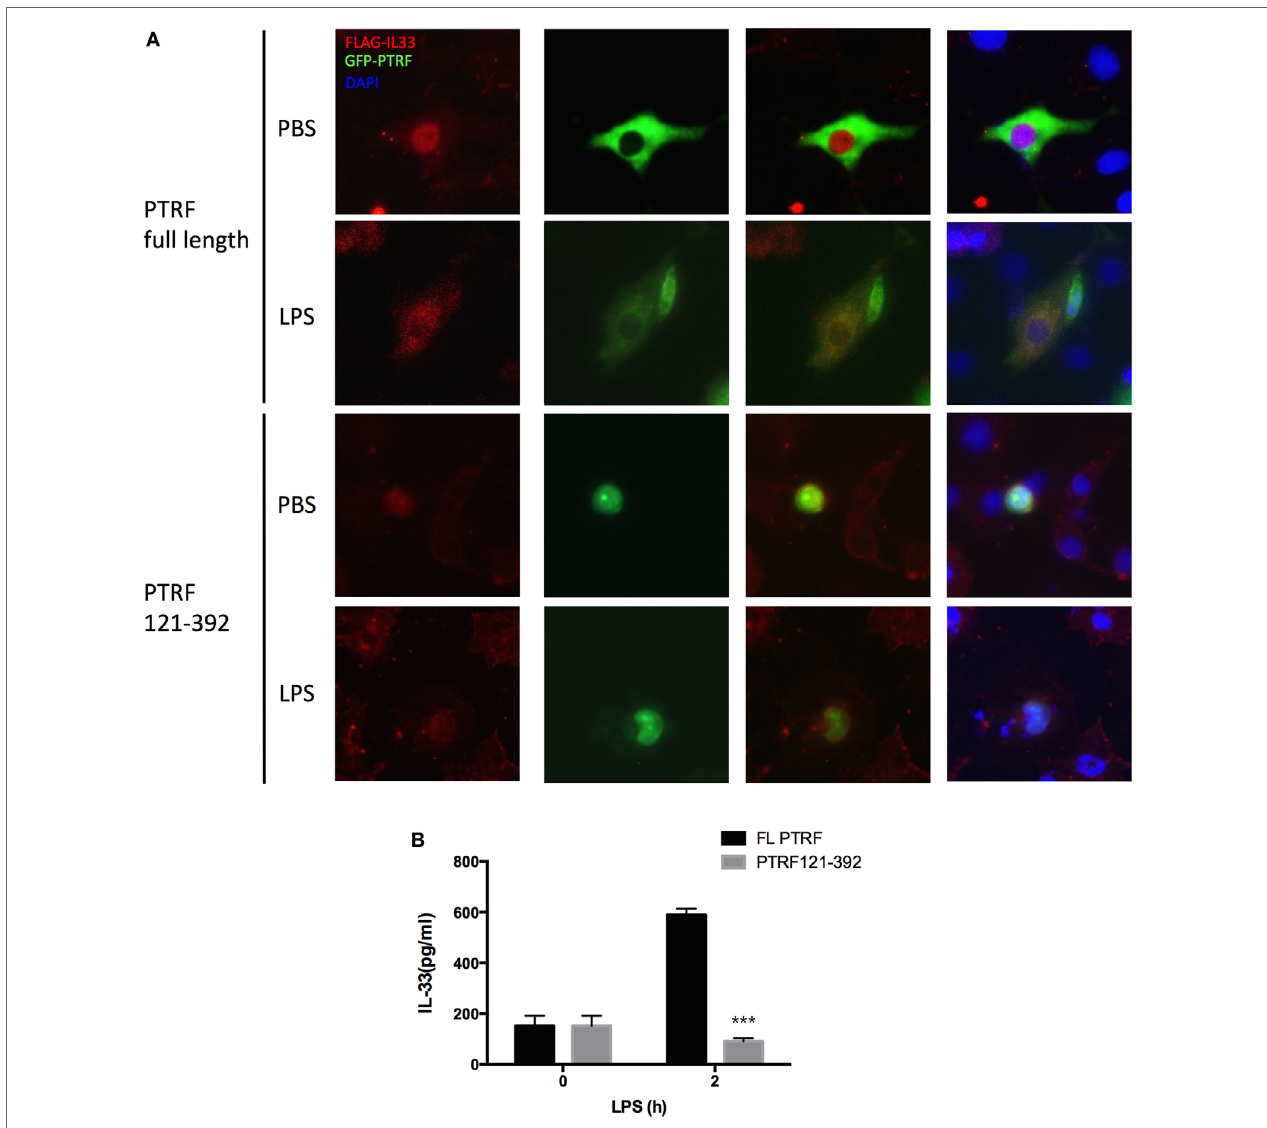
FigUre 5 | Polymerase I and transcript release factor (PTRF) controls IL-33 subcellular location. (a) Representative images of IL-33 (red) and PTRF (green) immunofluorescence of wide type PTRF or PTRF truncation 121-392 transfected HBE with or without LPS (1 ng/µl) treatment. (B) IL-33 levels in culture supernatants from wide type PTRF or PTRF truncation 121-392 transfected HBE with or without LPS (1 ng/µl)